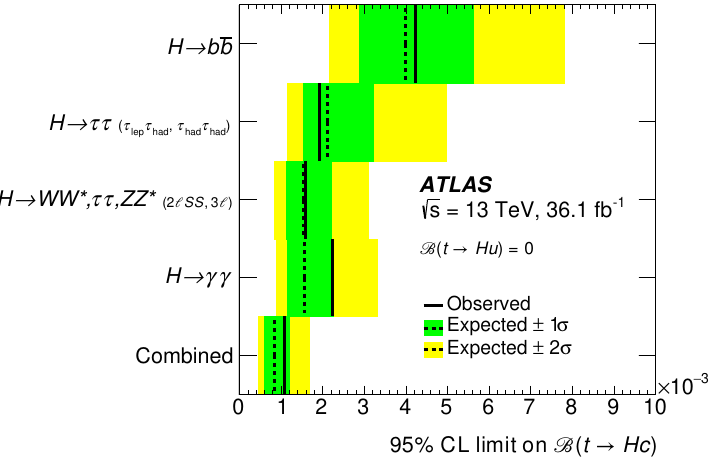
Figure 13 . 95% CL upper limits on B ( t ! Hc ) for the individual searches as well as their combination, assuming B ( t ! Hu ) = 0. The observed limits (solid lines) are compared with the expected (median) limits under the background-only hypothesis (dotted lines). The surrounding shaded bands correspond to the 68% and 95% CL intervals around the expected limits, denoted